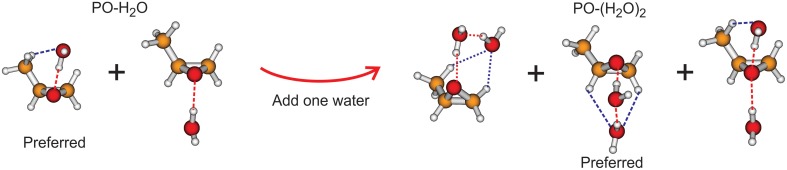
Geometries of the two and three most stable conformers of PO-(H2O)1,2 obtained at the MP2/6-311++G(d,p) level of theory, respectively. For the 1:1 Po-water complex, syn PO-water is preferred and for the 1:2 PO-(water)2 complex, anti PO-(water)2 is the preferred conformation (Su et al., 2006; Su and Xu, 2007a,b).